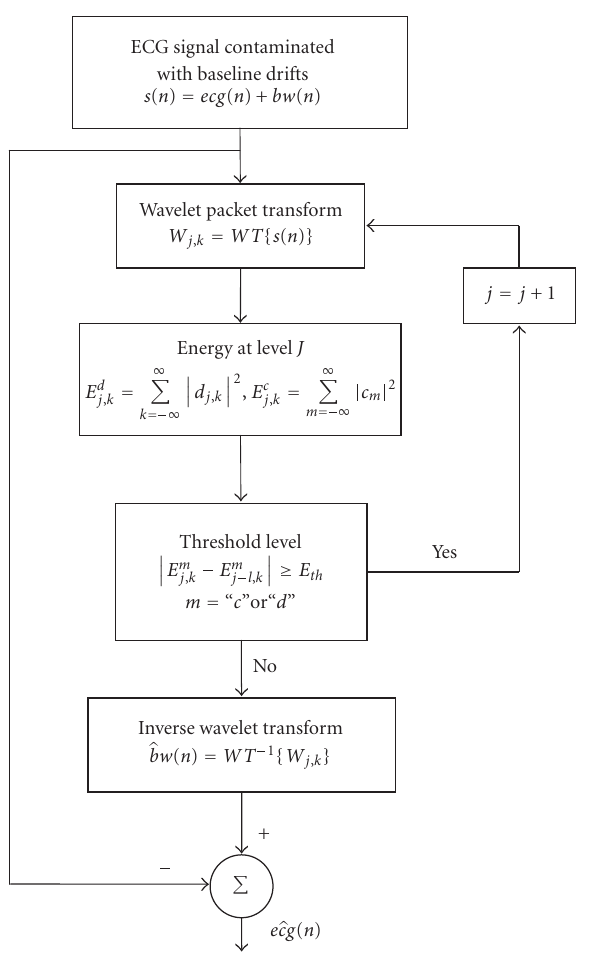
Figure 4: Block diagram of ECG baseline remover